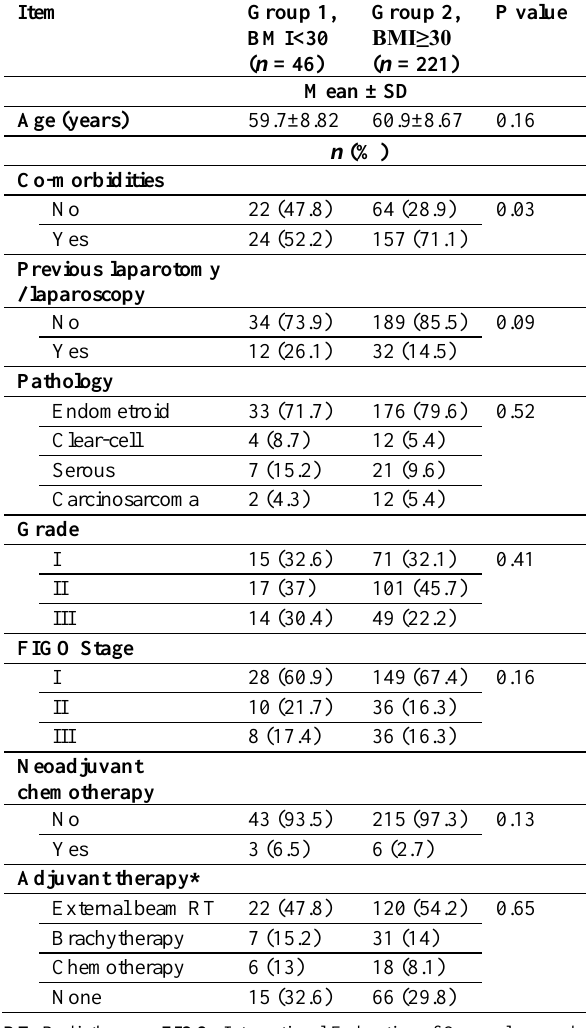
Table 1: Patients’ characteristics according to